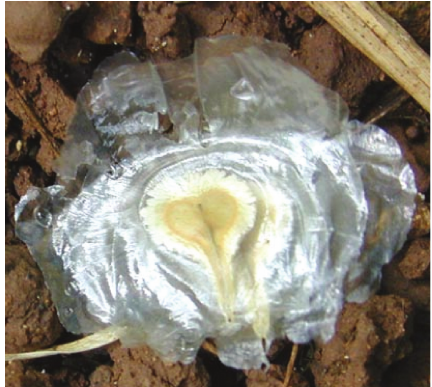
Figure 1: Translucent and thin cuticle holding Nandi flame